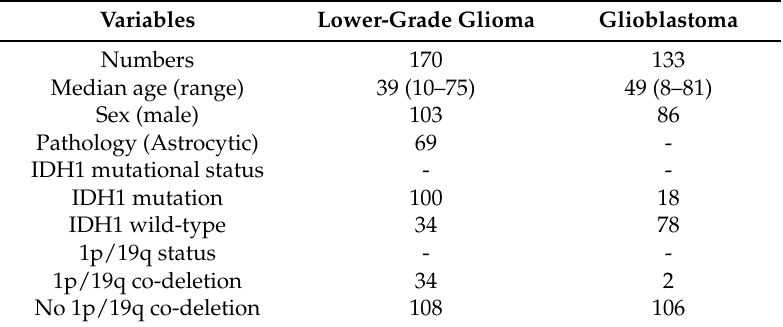
Table 1. Clinical characteristics of 303 glioma patients.